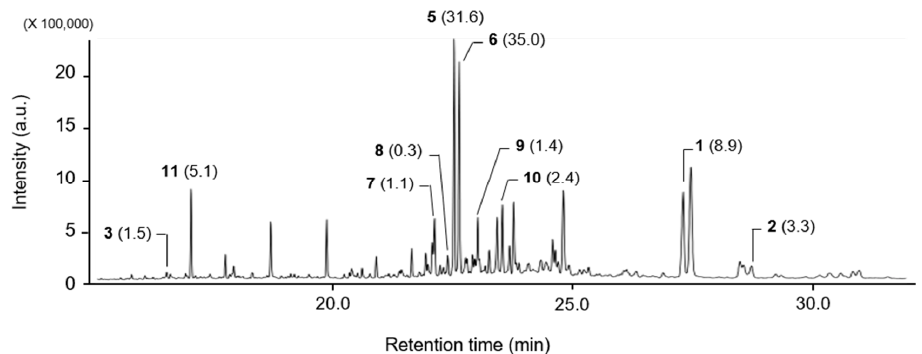
Figure 4. Constituent analysis of the Platycladus orientalis EtOAc fraction. Parentheses indicate relative peak area (%) of each compound. 1 , pinusolide; 2 , 15-methoxypinusolidic acid; 3 , lambertianic acid; 5 , sandracopimaric acid; 6 , isopimaric acid; 7 , sandaracopimaradien-3 β -ol; 8 , isopimara-7,15-dien-3 β -ol; 9 , 8 β ,18-dihydroxysandaracopimar-15-ene; 10 , 15-isopimaren-3 β ,8 β -diol; 11 , α -cedrol.